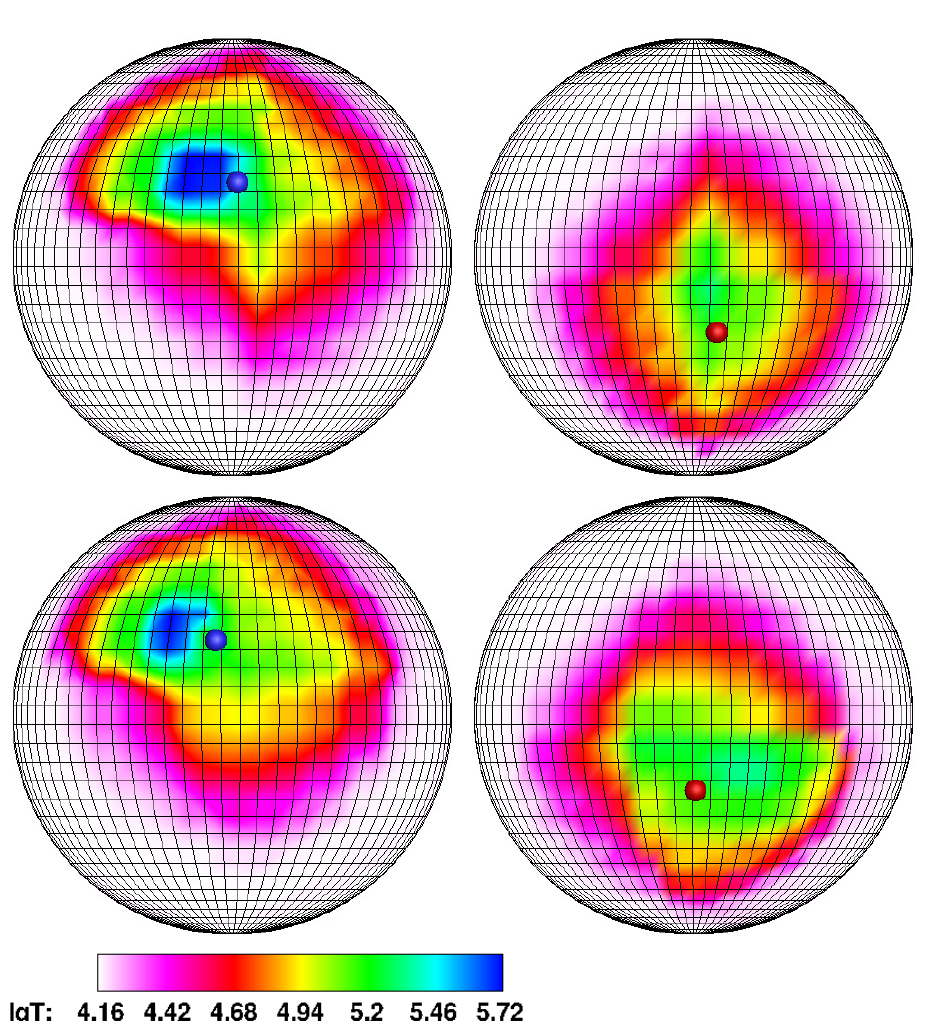
Figure 16. Temperature distribution over the accretor surface for the asynchronous polar with an non- offset dipole when switching the flow from the north magnetic pole to the south one. Temperature maps for Phase 1 ( upper panel) and for Phase 2 ( lower panel) are